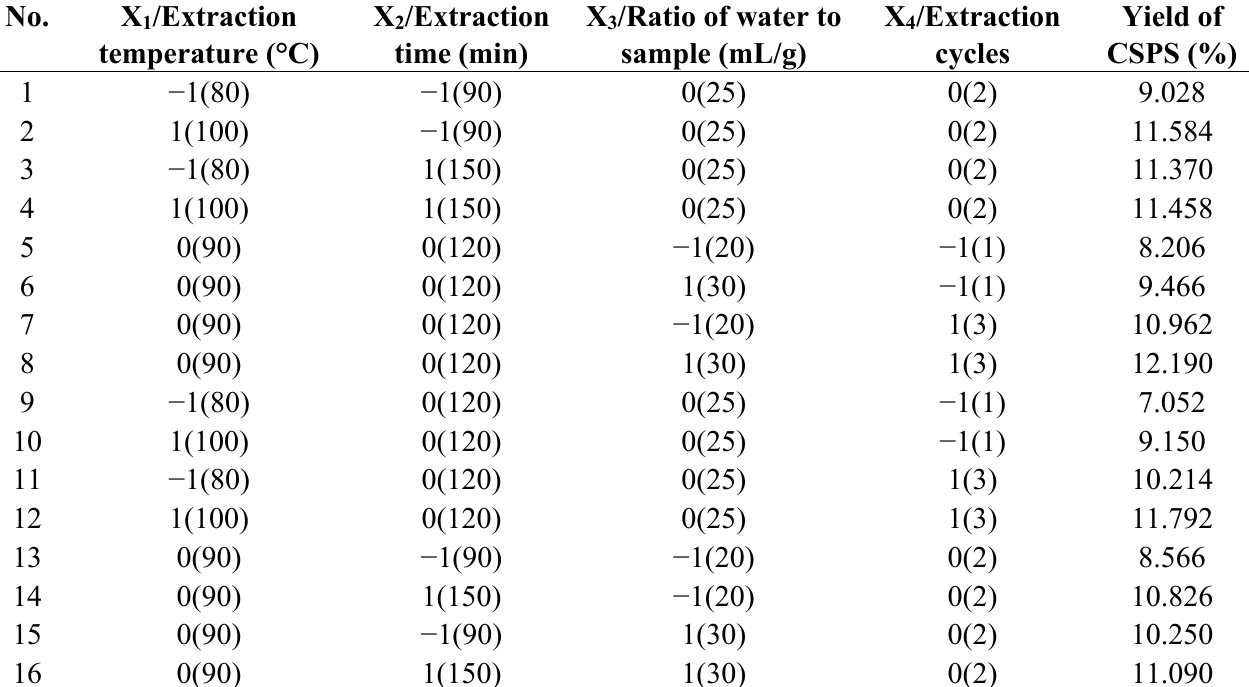
Table 1. Box-Behnken design matrix of four variables and the experimental observed responses.